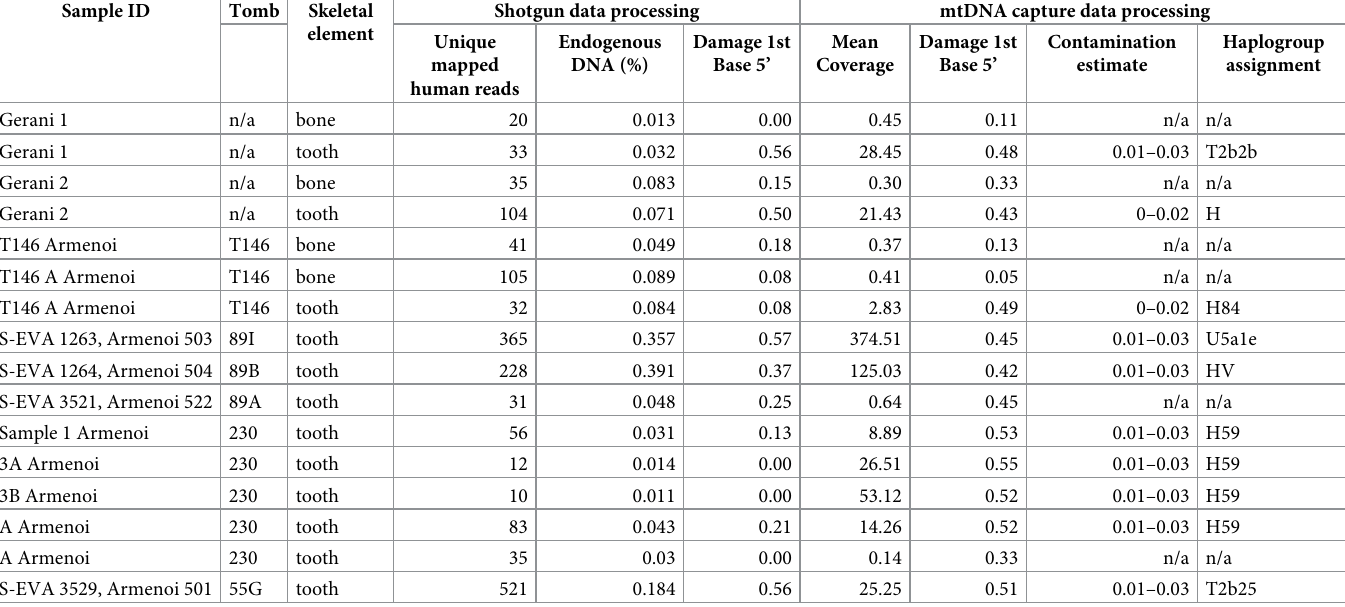
Table 6. mtDNA results (haplogroup, coverage, contamination estimation) from 12 Bronze Age humans from the site of Armenoi, and two Neolithic humans from the site of